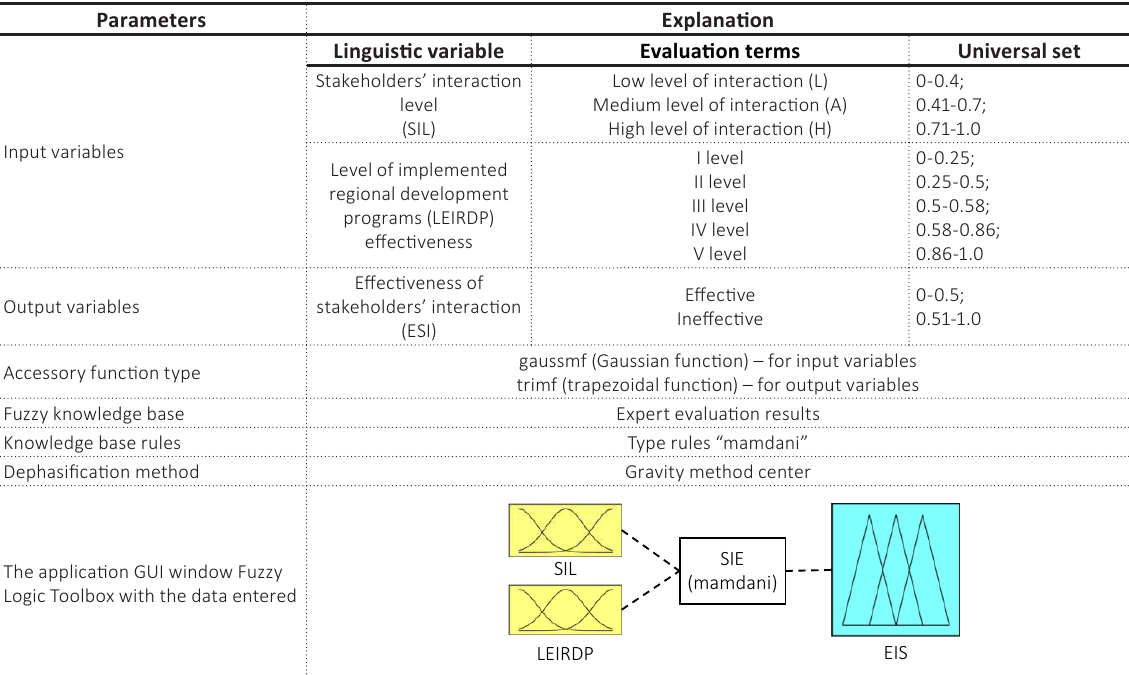
Table 1. Parameters of a stakeholder interaction evaluation fuzzy